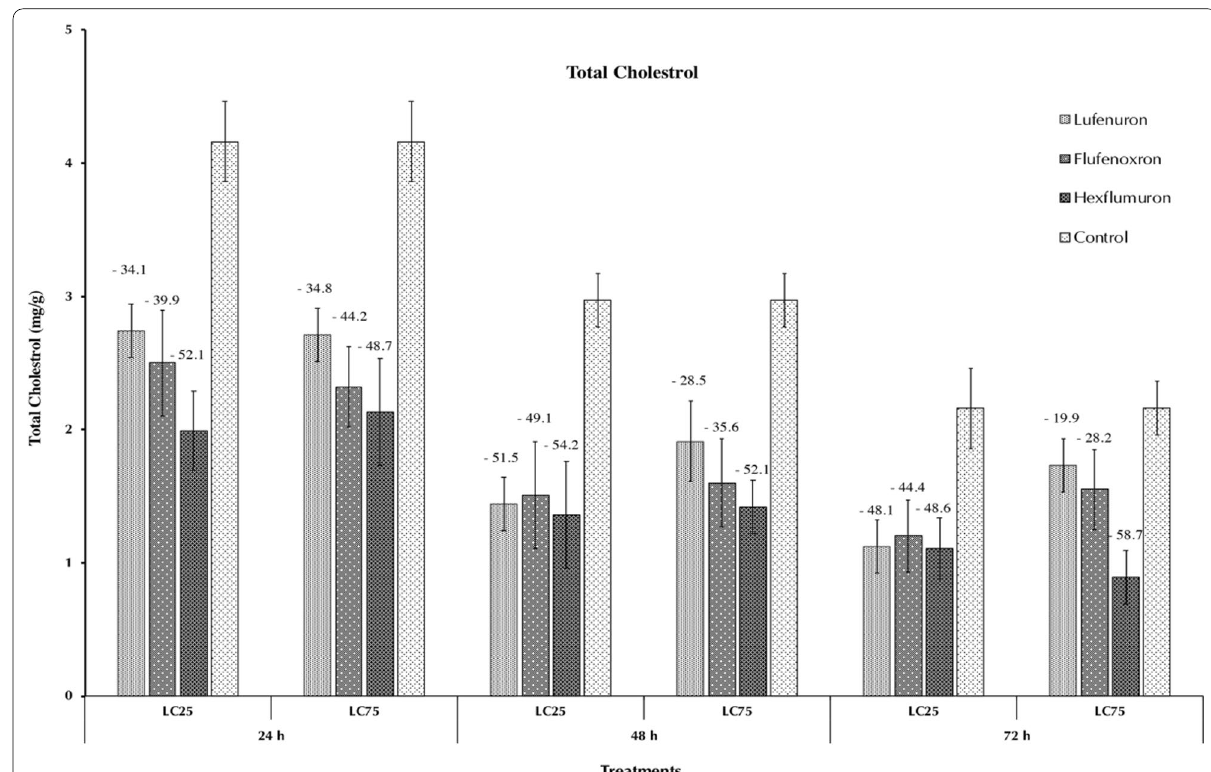
Fig. 1 Effects of LC 25 and LC 75 concentrations of lufenuron, flufenoxuron and hexaflumuron on the total cholesterol content of the house fly, Musca domestica 2 nd larval instar tissue homogenate tested at various time intervals . The change percentages are included upon each column. Data presented as mean with SD of three